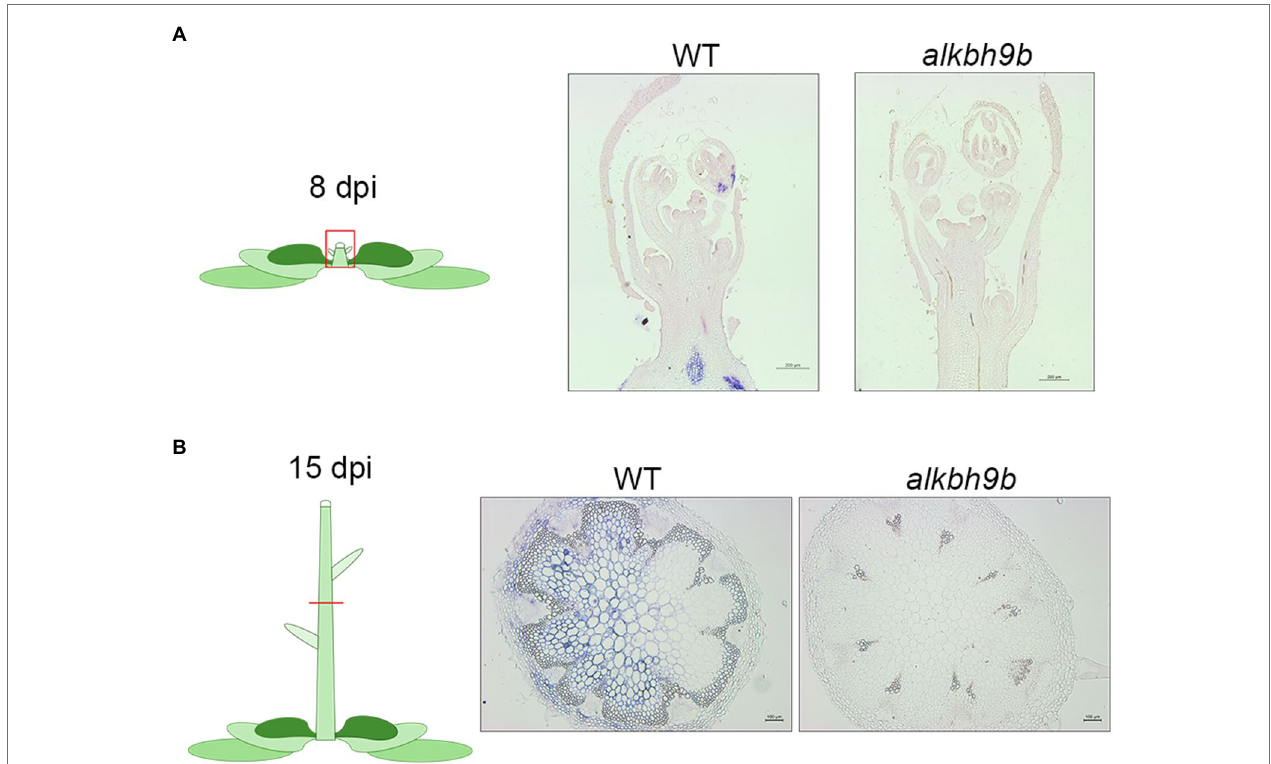
FIGURE 3 | AMV usually does not invade vascular tissue in AMV plants. Representative pictures of the SAMs (A) and floral stems (B) from WT and alkbh9b plants at 8 and 15 dpi, respectively. Scale bars correspond to 200 μ m (a) or 100 μ m (b).